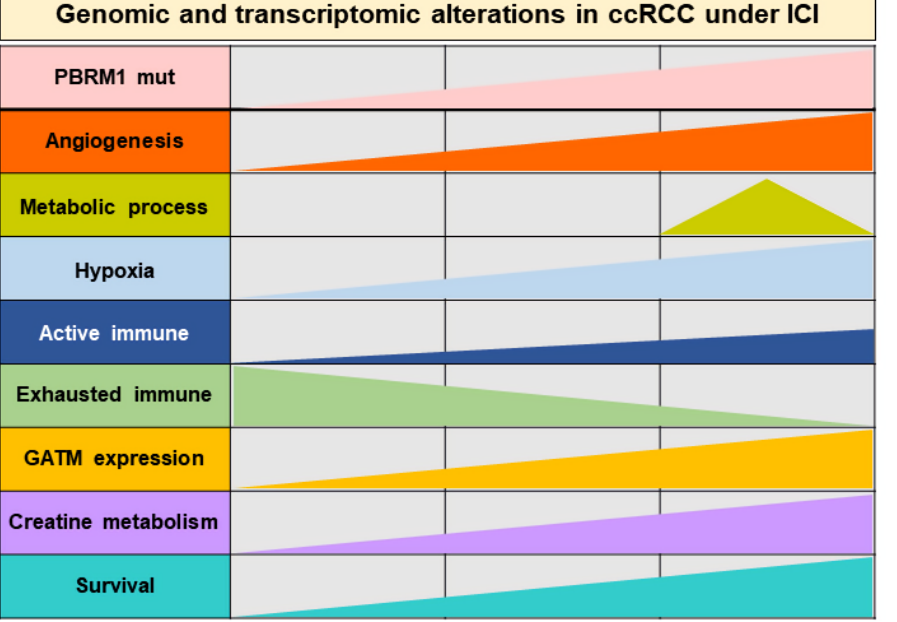
Figure 7. Graphical summary of the dynamics of genomic and transcriptomic aberrations in patients with metastatic clear cell renal cell carcinoma.